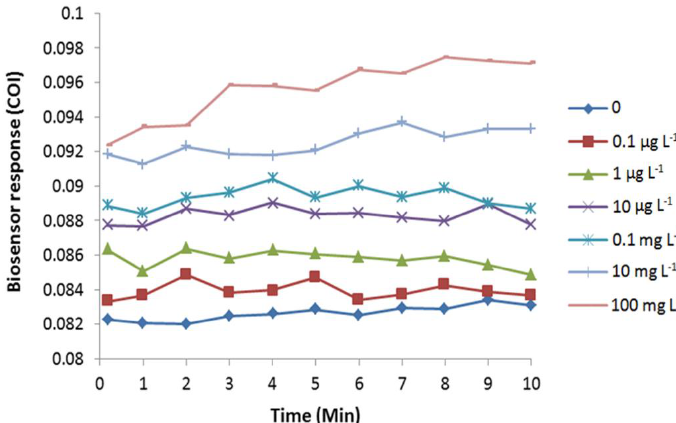
immobilized in 1.8% (w/v) KC at 4.5 × 10 8 cfu·mL −1 .